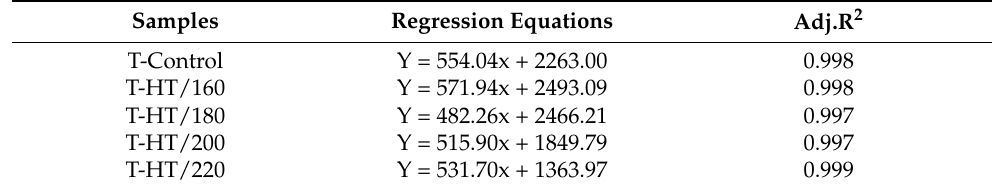
Table 2. The regression equations obtained by linear fitting of peak area and MC for samples with water absorption in the T direction.